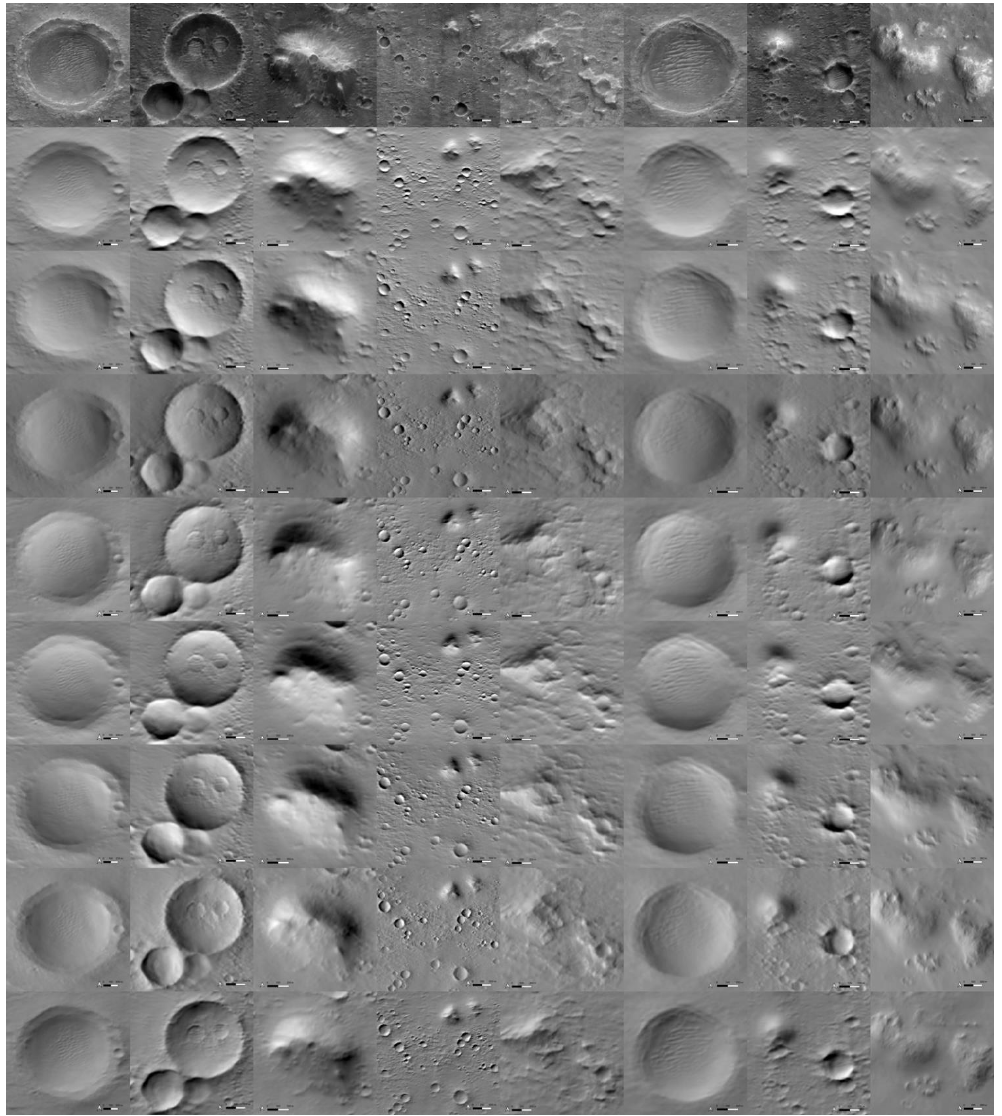
Figure 10. Hill-shaded images of 8 different crops (from 1st column to the 8th column) of peaks and craters from the resultant CaSSIS MADNet DTM using 8 different illumination angles (from the 2nd row to the 9th row at 45° increments, i.e., 0°, 45°, 90°, 135°, …, 315°. The original CaSSIS image crops is displayed in the 1st row. N.B. elevation of the light source is 30° for all azimuths.